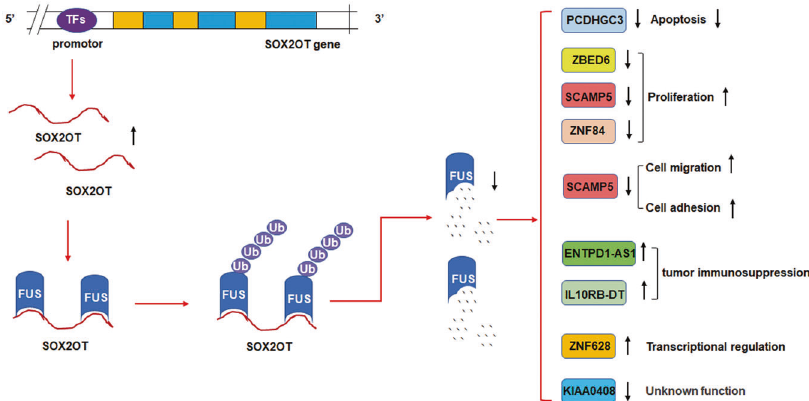
Fig. 6 Schematic representation for the mechanism of SOX2OT – FUS axis in pancreatic cancer progression. SOX2OT may bind to FUS protein to promote its degradation via ubiquitination, thereby promoting cell proliferation, migration, and invasion, then affecting the development of pancreatic